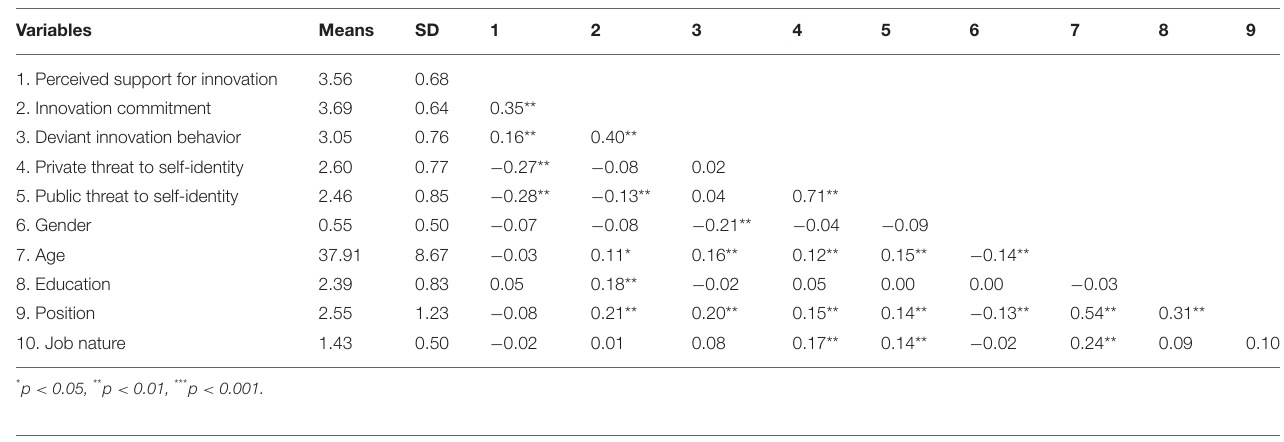
TABLE 2 | Results of the path analysis of the mediating effect. Path Estimate SE Lower and upper